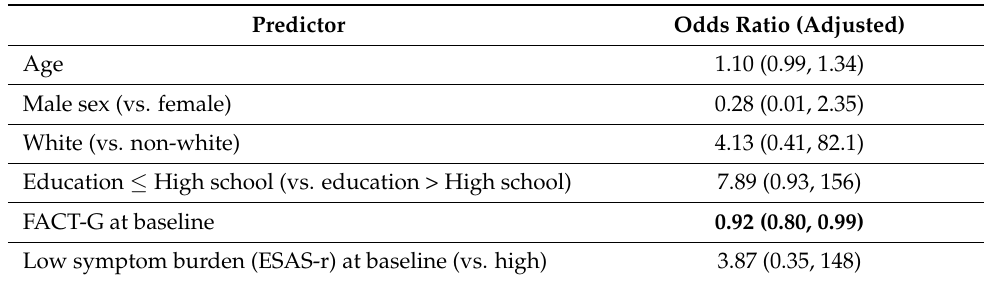
Table 4. Logistic Regression Model to examine the importance of baseline variables in predicting hospice use of those who died ( N =